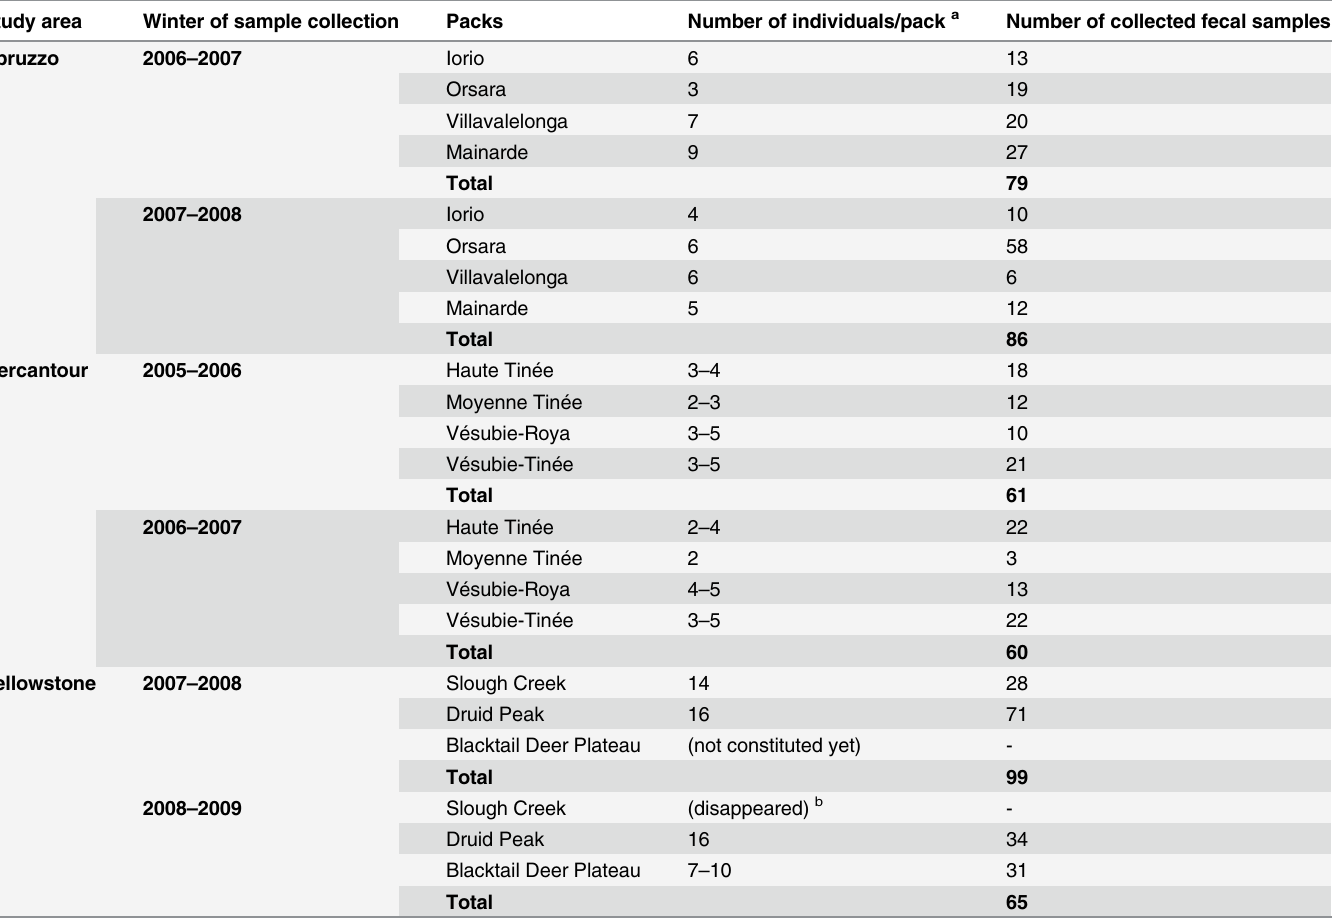
Table 3. Group size and number of fecal samples collected from the investigated wolf packs in the three study areas, 2005 –